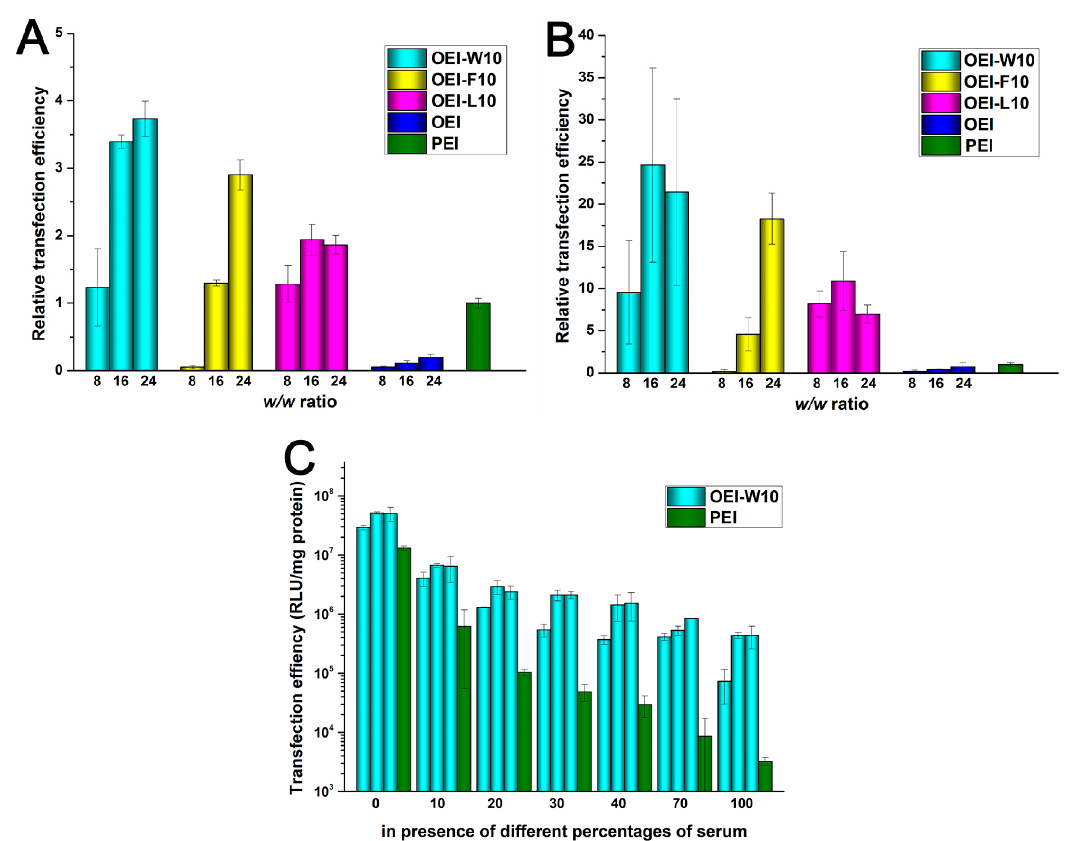
Figure 6. Luciferase gene expression transfected by polyplexes at different weight ratios (( A , B ) Relative TE by normalizing the TE of PEI ( w / w = 1.4) as 1; ( C ) absolute TE) in HeLa cells. Data represent mean ± SD ( n = 3). ( A ) Without serum; ( B ) With the presence of 10% serum; ( C ) Effect of serum concentration on the TE (weight ratio for OEI-W10 : 8, 16 and 24).